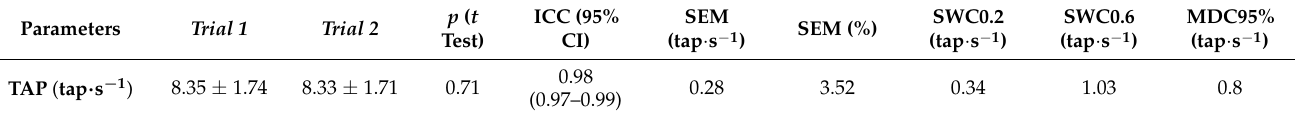
Table 2. Reliability results of